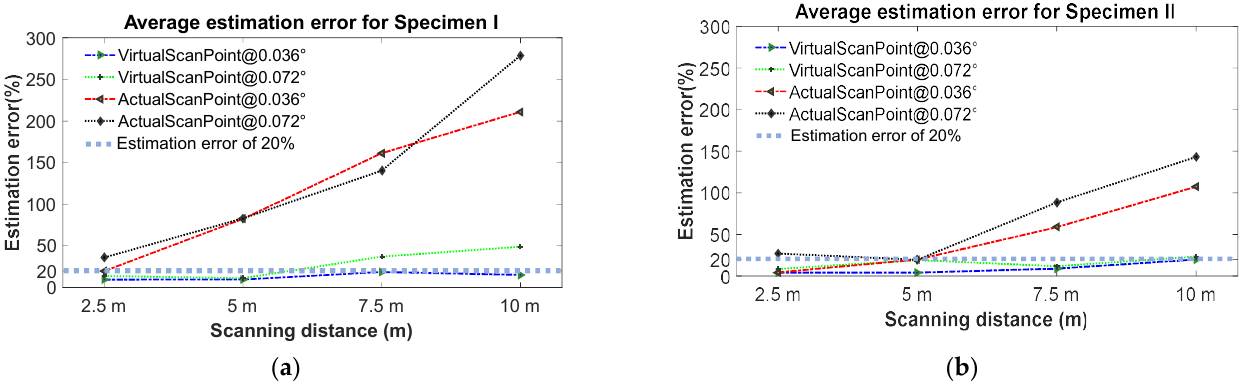
Figure 9. F F number estimation errors under various angular resolutions and scanning distances: ( a ) average estimation error for specimen I and ( b ) average estimation error for specimen II.